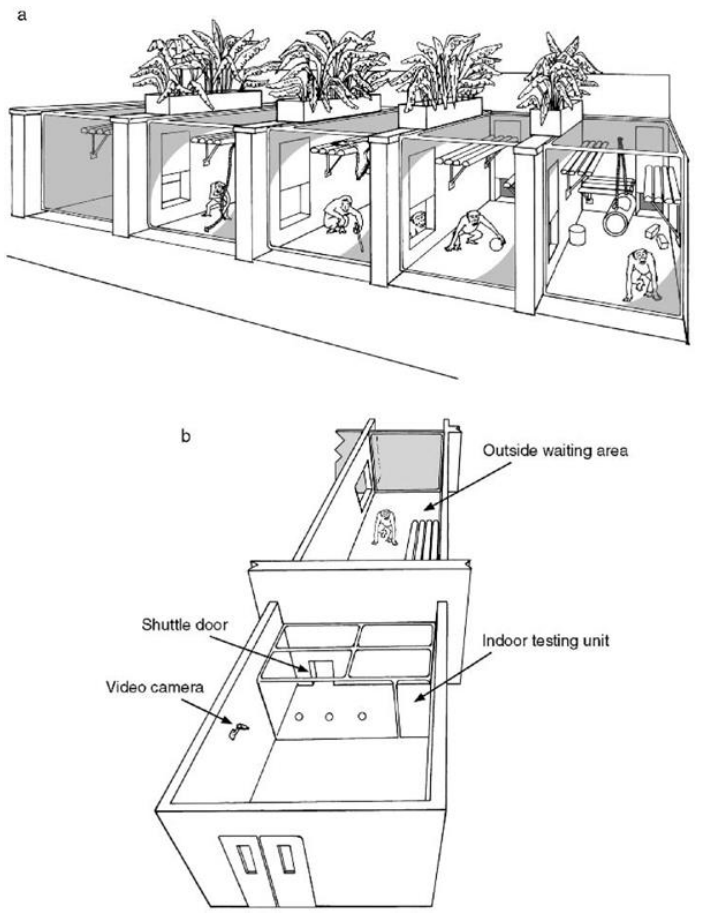
The Living Quarters Created for the Seven Young Chimpanzees used by Daniel Povinelli for his Series of Experiments to Understand the “Chimpanzee Mental